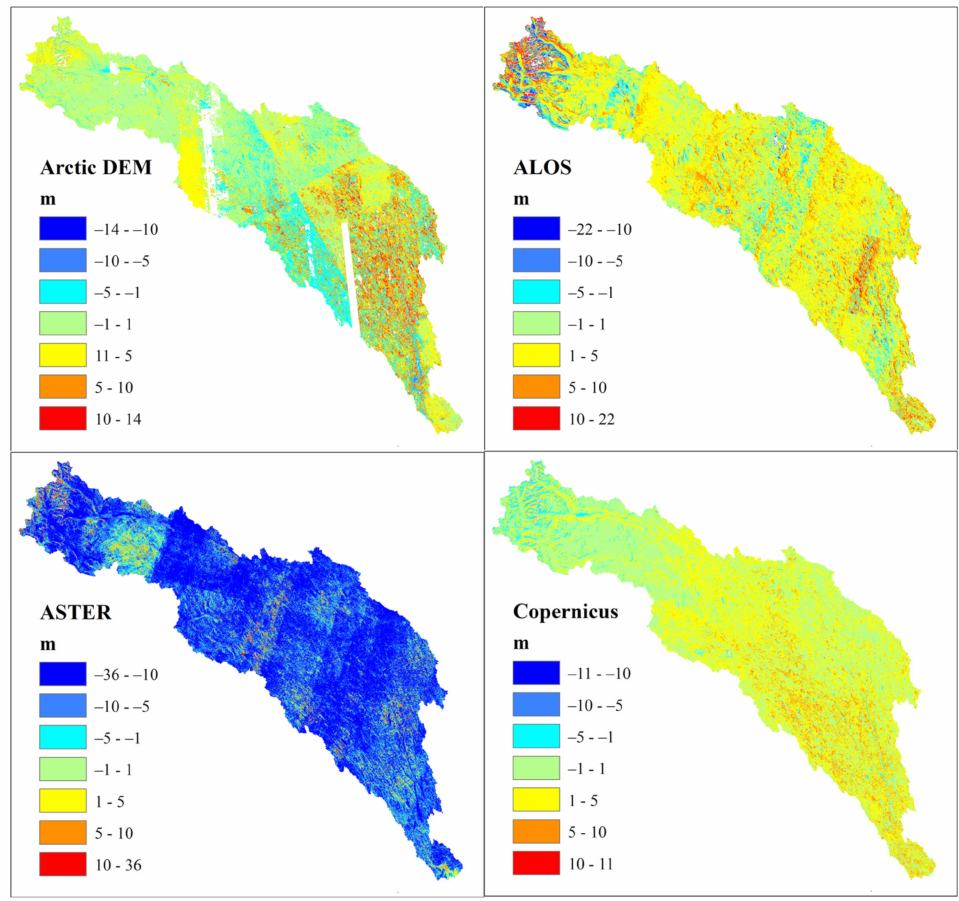
Figure 3. Differences in elevation when candidate DEMs were compared with the reference